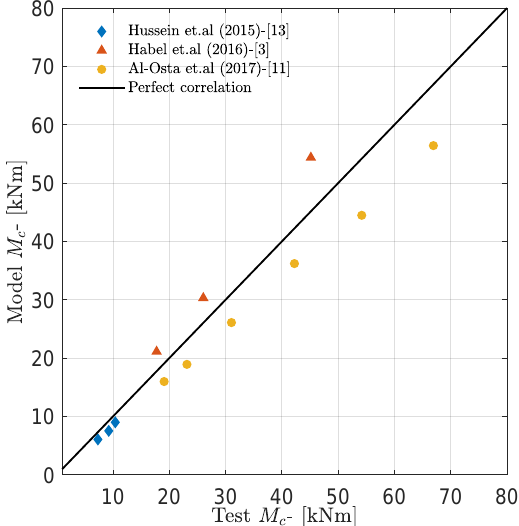
Figure 3. Comparison of a proposed analytical pro- cedure with experimentally predicted moment capac-